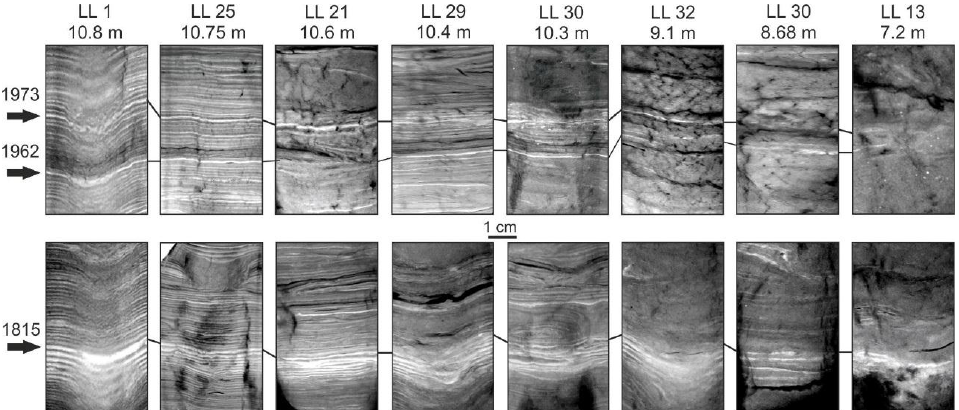
Figure 4. X-ray images representing core correlation based on variations in lithological marker horizons and the succession of varves. The arrows point at clastic laminae that were formed in 1815, 1962, and 1973 as easily discernible components of marker horizons.